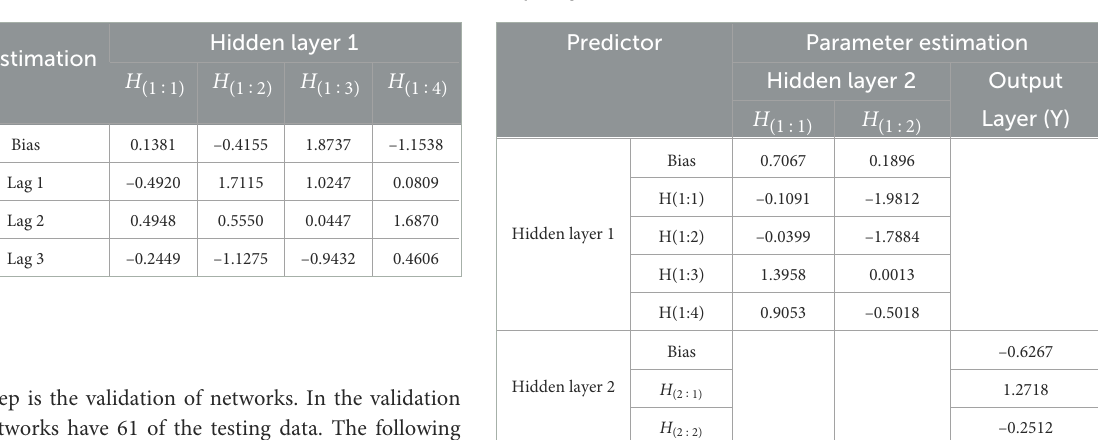
TABLE 8 Parameter estimation of FFNN model from input layer to hidden layer 1.